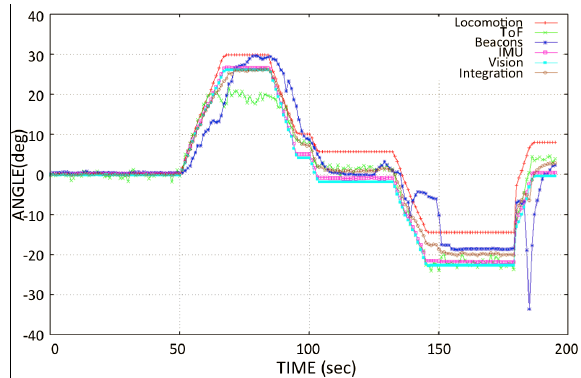
Figure 17. Navigation test: Orientation from different sensory systems during the robot’s angular movement.